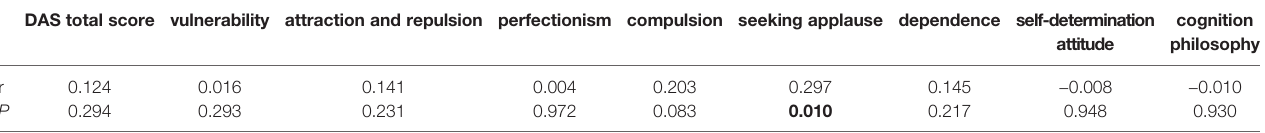
TABLE 6 | Correlations between the changes of HAMD 24 and changes of C-DAS-A total and factor scores before and after treatment in the rMDD subgroup. DAS total score vulnerability attraction and repulsion perfectionism compulsion seeking applause dependence self-determination